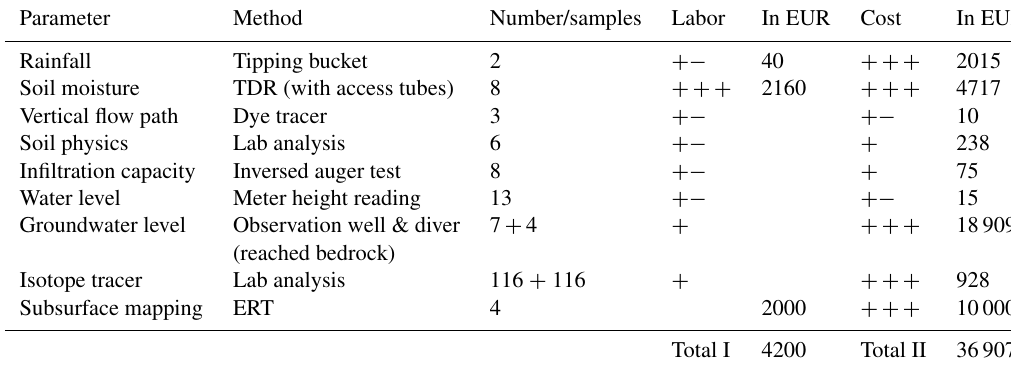
Table A3. Vietnam Case, scenario 3: to map the subsurface. Parameter Method Number/samples Rainfall